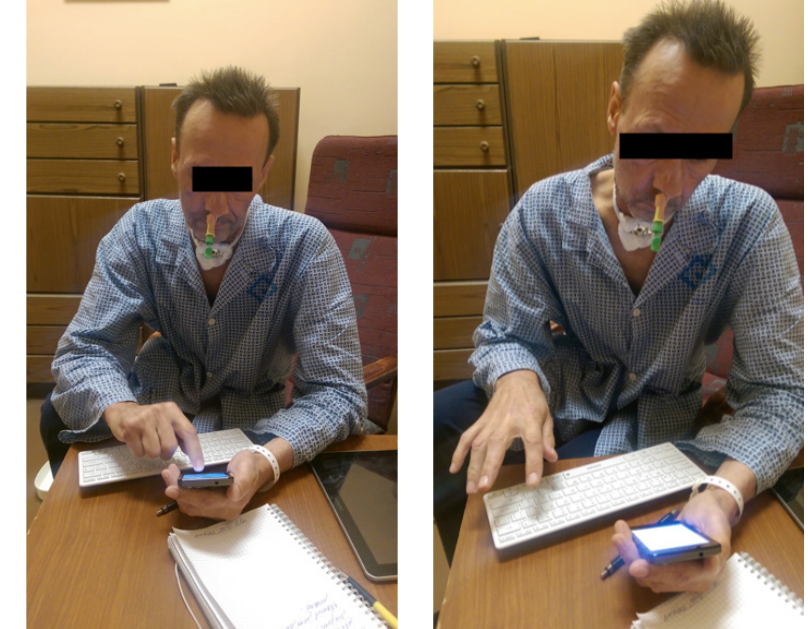
Fig. 1. Patient using TTS device in the immediate postoperative